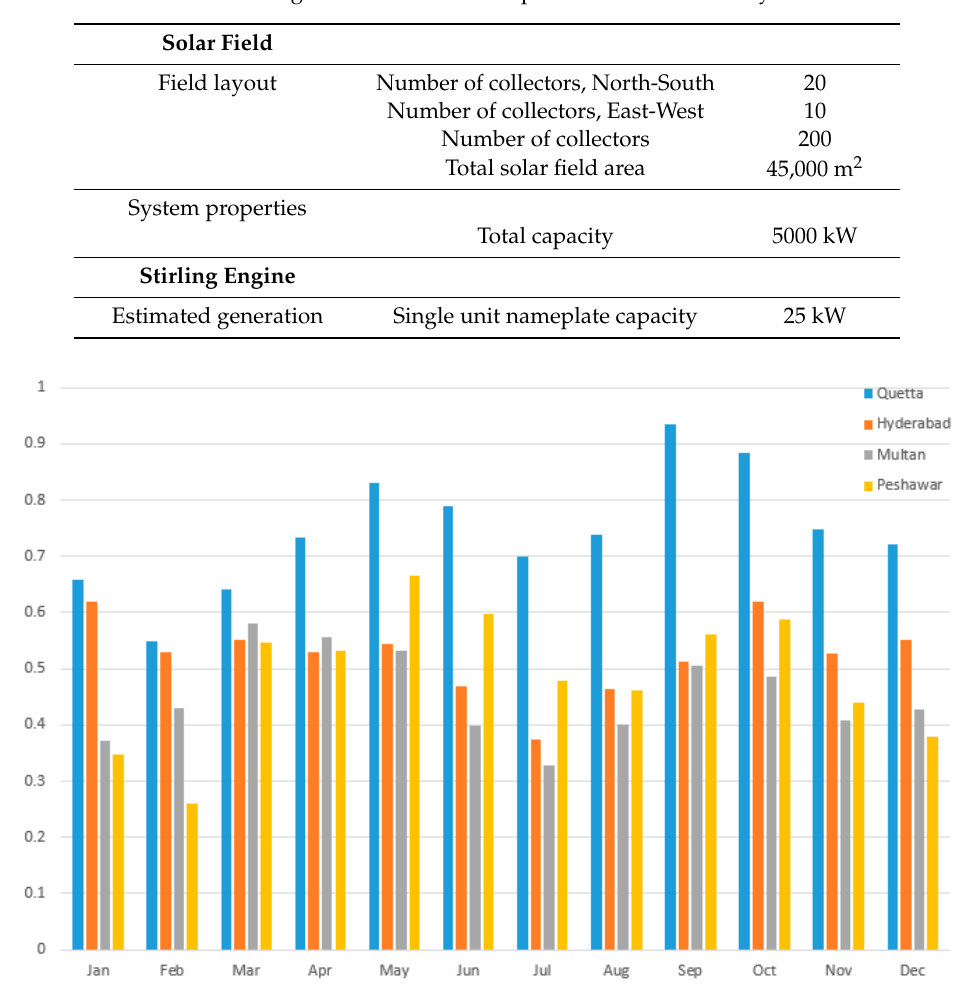
Table 13. Design characteristics and specifications of the PD system.